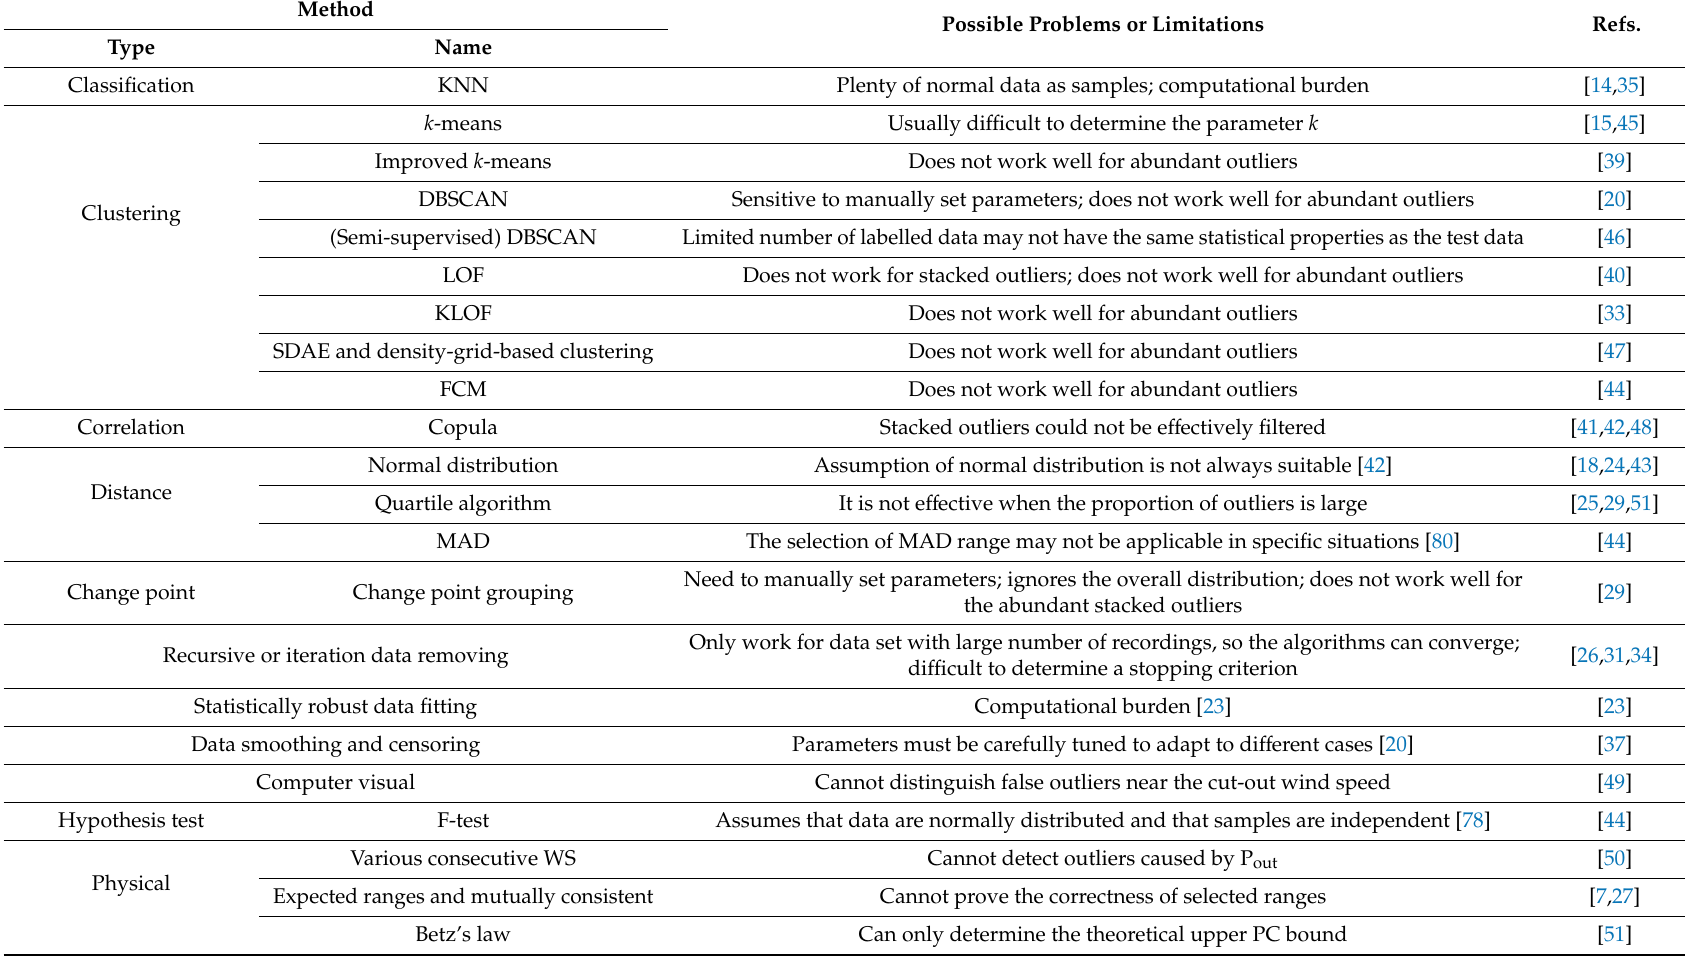
Table 4. Summary of possible problems or limitations of reviewed outlier detection methods in practical